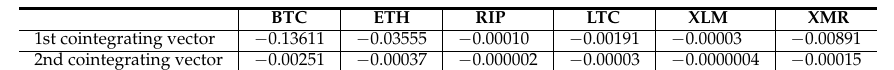
Table 6. Estimates of the speed of adjustment parameters α for the six crypto-asset system. All estimates are 1% statistically